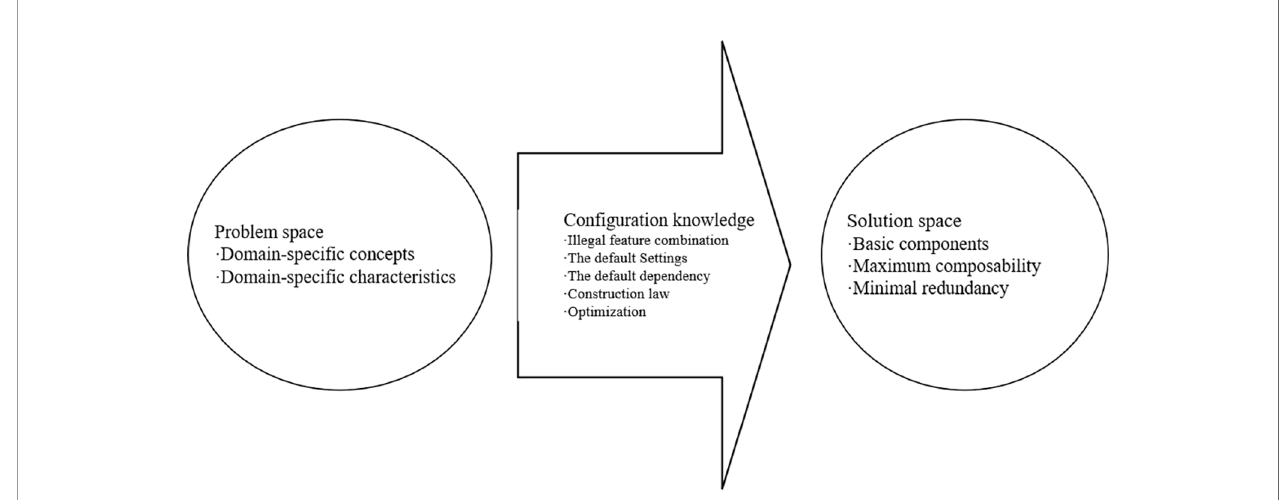
FIGURE 1 | Composition of generative domain